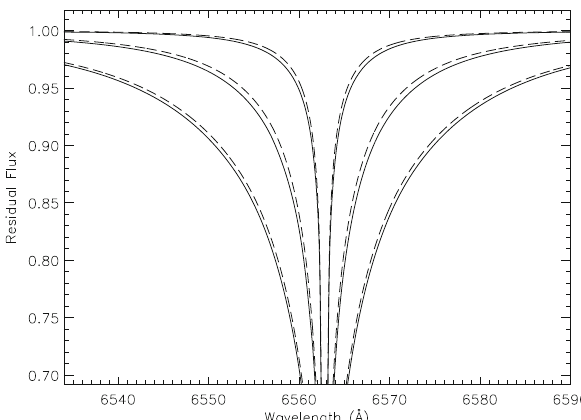
Fig. 6 Sensitivity of computed profiles for H α with the stellar effective temperature ( T eff = 5000, 6000, 7000K),foranatmospherewithsolarsurfacegravityandcomposition. Strongerlines correspondtowarmer atmospheres.Thedifferencesbetween solid and dashedprofiles illustratevariationsbetweentwotheoretical calculations of the contribution of H–H collisions. Image reproduced with permission from Barklem et al. (2000), copyright by